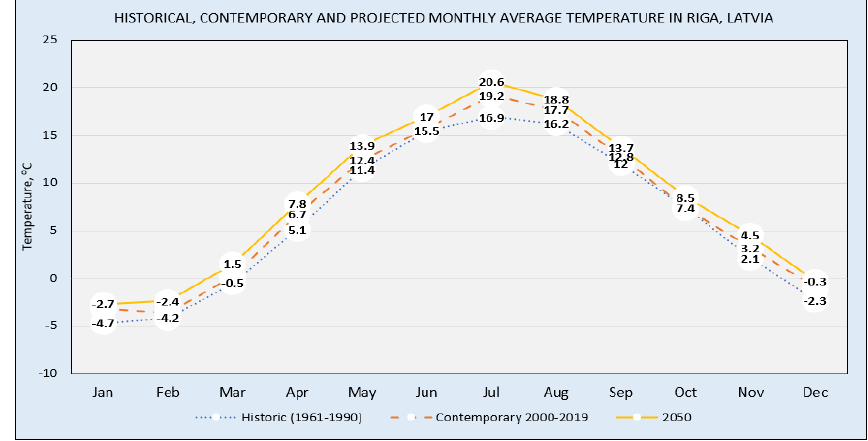
Fig. 1. Historical, contemporary, and projected monthly temperature averages for Riga,